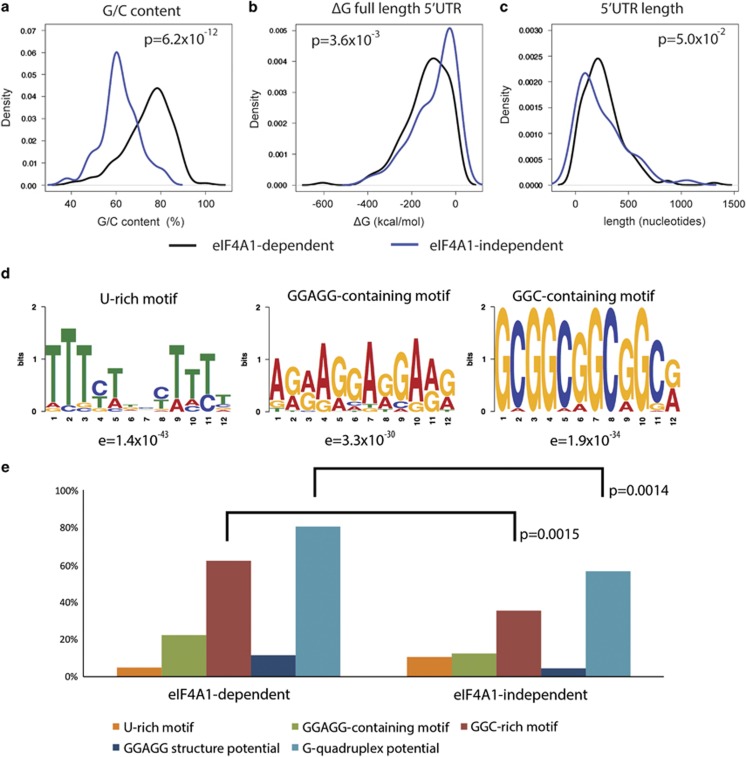
eIF4A1-dependent and -independent mRNAs have qualitatively different 5′UTRs. eIF4A1-dependent and -independent mRNA 5′UTRs were characterized in terms of (a) G/C content, (b) predicted folding stability and (c) 5′UTR length. P-values were calculated using Kolmogorov-Smirnov test. (d) Recurrent sequence motifs were discovered in the eIF4A-dependent 5′UTRs. (e) GGC-containing motifs were enriched in eIF4A-dependent sequences, as was the predicted potential to form classical G-quadruplexes